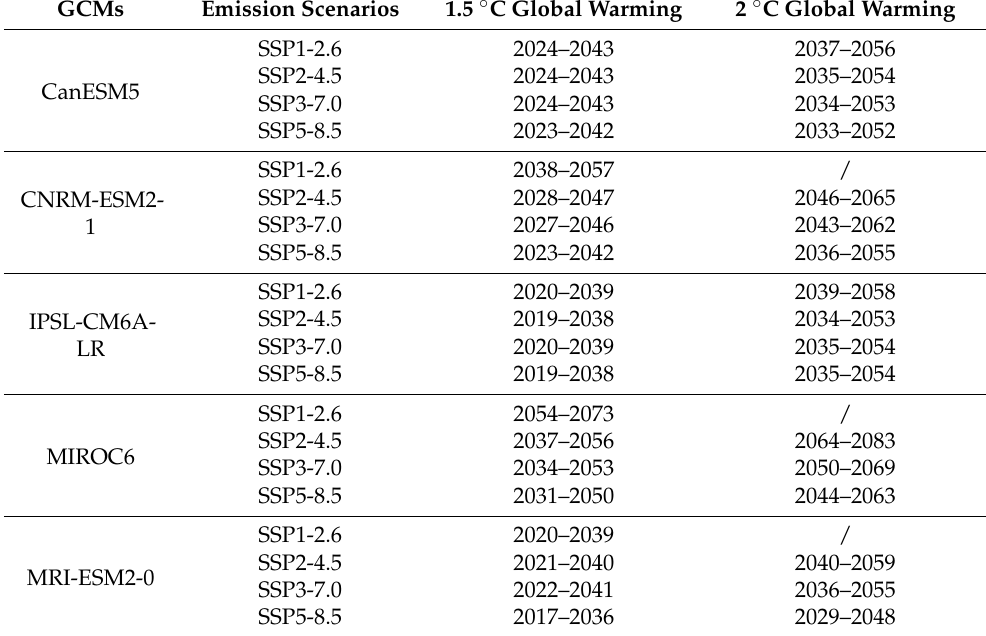
Table 5. Time spans of 1.5 ◦ C and 2.0 ◦ C global warming under SSPs emission scenarios.